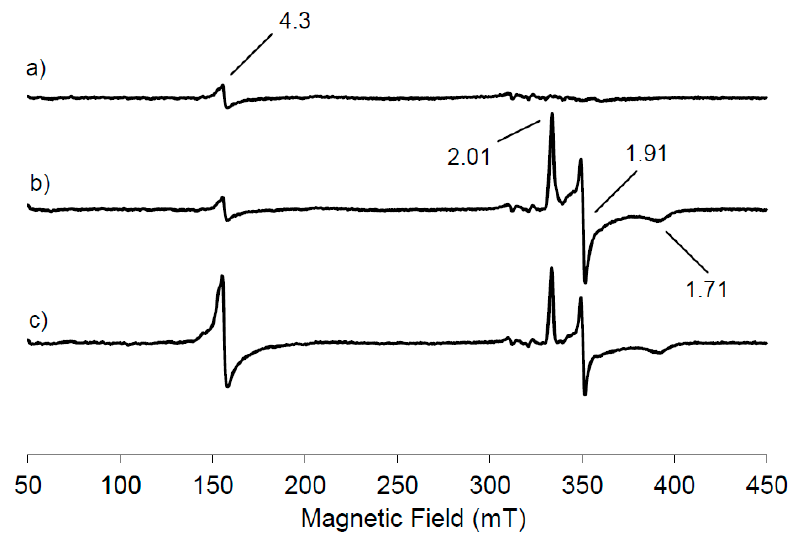
Figure 1. Low temperature (20K) electron paramagnetic resonance (EPR) spectra of naphthalene 1,2-dioxygenase (NDO) samples collected after 10s before freezing in liquid nitrogen: ( a ) in the native state, ( b ) reduced by sodium dithionite and ( c ) reduced NDO after treatment with O 2 -saturated naphthalene. All spectra were recorded at 9.38 GHz, 1mT modulation amplitude, 2 mW microwave power and 100 KHz modulation frequency.